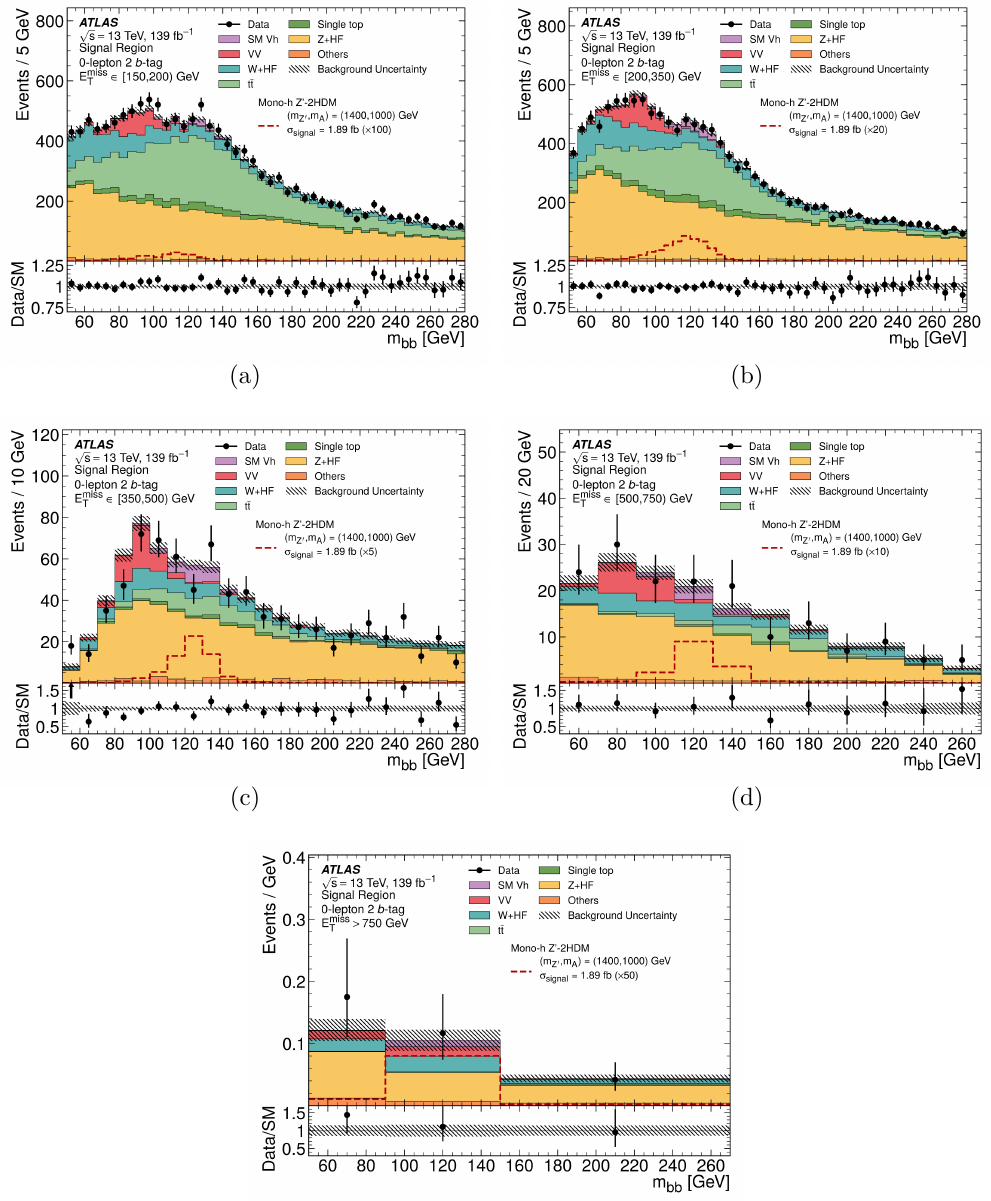
Figure 4. Distributions of the Higgs boson candidate mass in the 2 b -tag signal regions for different E miss ranges. The top panel comparies the fitted background yields with data, while the T bottom panel indicates the ratio of the observed data to the predicted Standard Model backgrounds. The background yields are obtained in a background-only fit to data. An example signal model from the Z 0 -2HDM with parameters ( m Z 0 , m A ) = (1400 GeV , 1000 GeV ) and a cross-section of 1.89 fb is displayed for comparison. The signal is scaled by the factors indicated in the legend for better